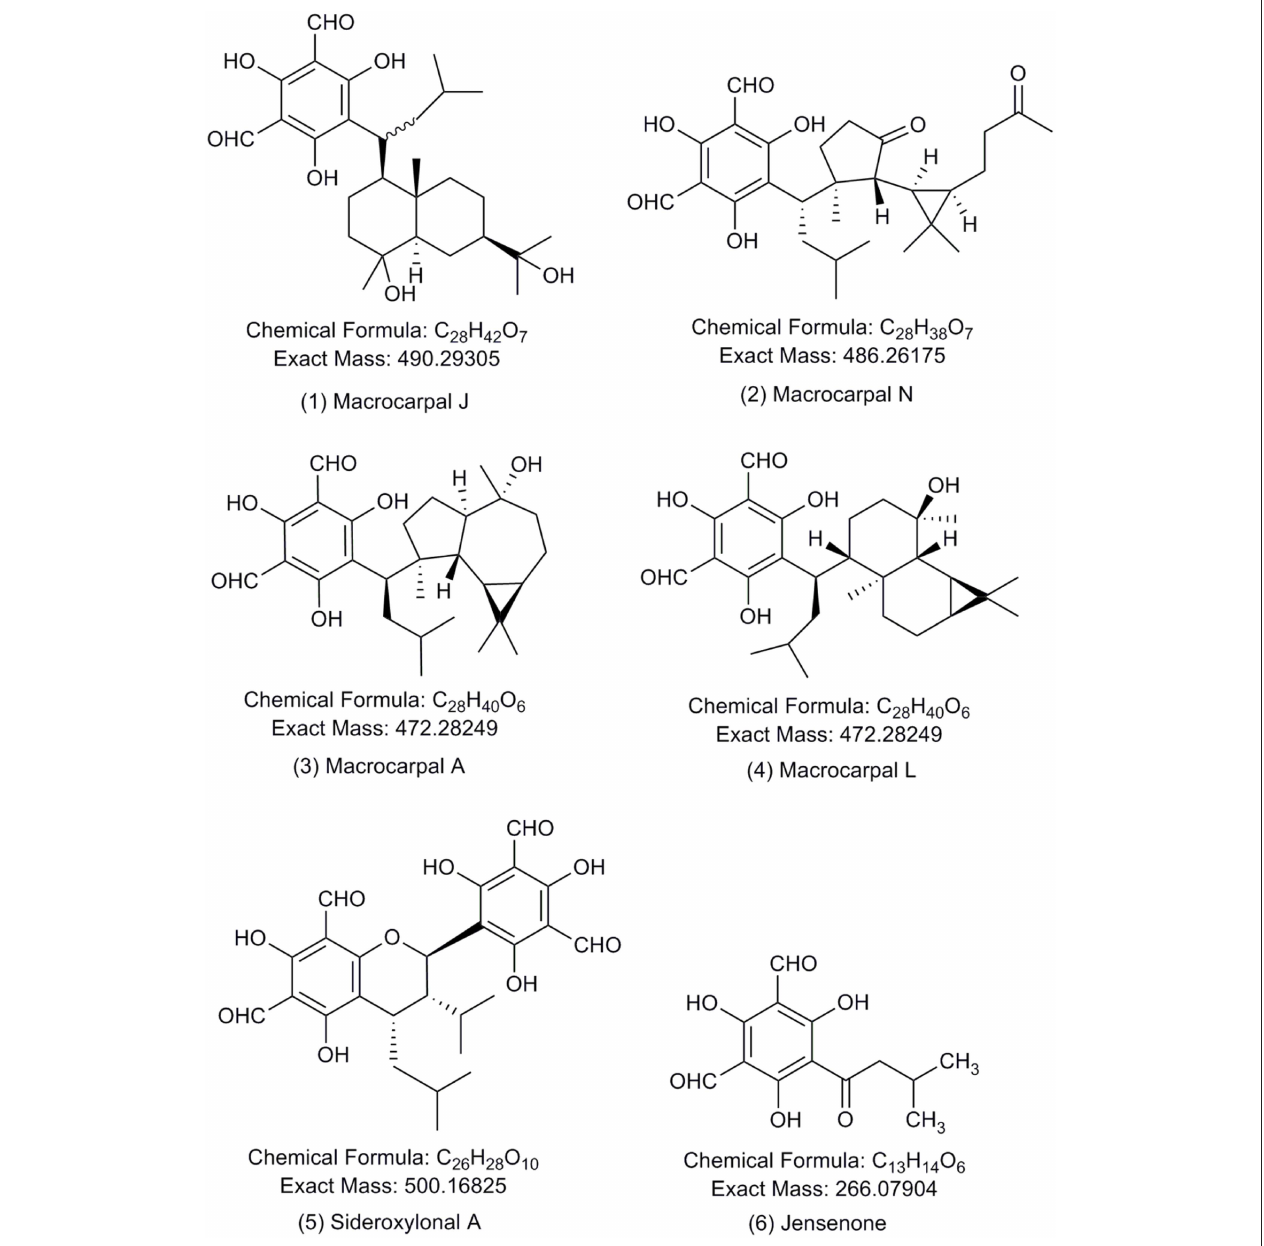
FIGURE 1 | Chemical structures of the formylated phloroglucinol compounds (FPCs). Authentic analytical standards for compounds 1–5 were used in this study. Number of each compound corresponds to text and other figures.